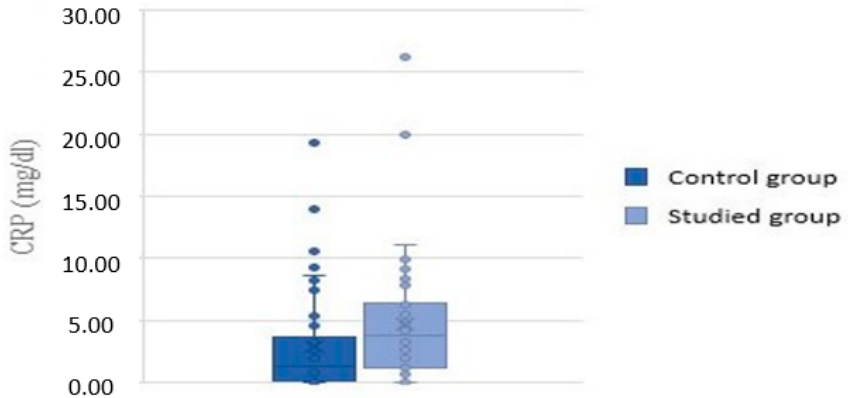
Figure 3. CRP values in the control and study groups.